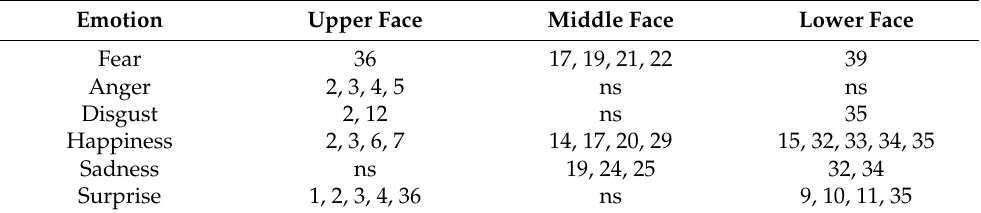
Table 2. Statistically significant ratios obtained per each emotion and face region. ns = non-significant.